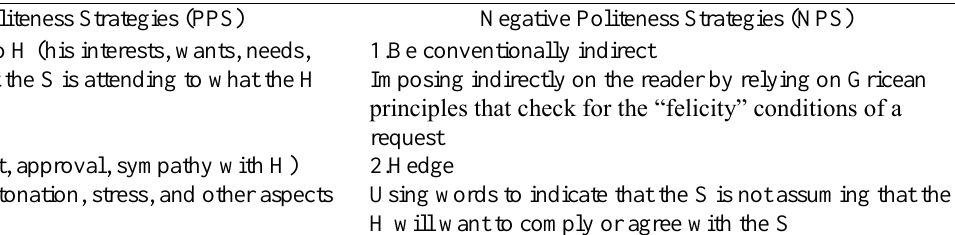
TABLE 1 | Codes for politeness strategies and the